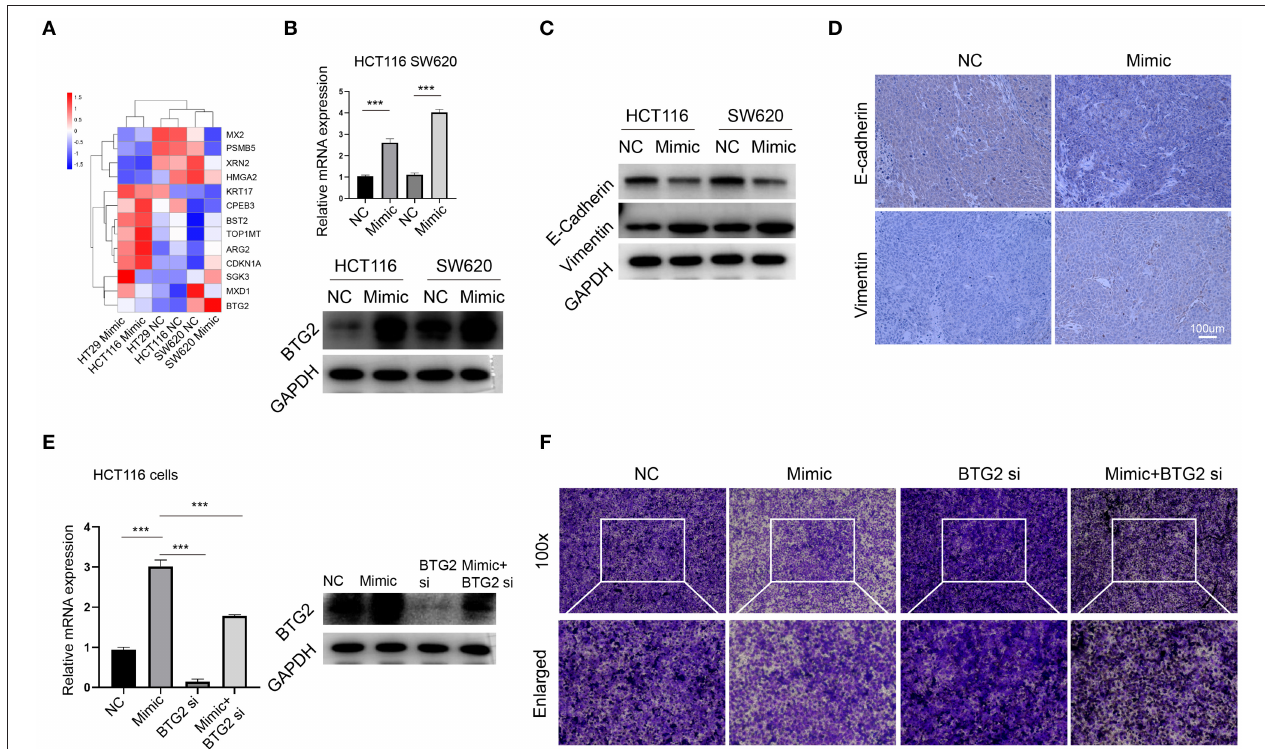
FIGURE 7 | miR-1278 inhibits migration through upregulation of BTG2. (A) Compare the expression of 13 genes consistently altered in three CRC cell lines presented by heat map. (B) The mRNA expression of protein expression of BTG2 was determined by qRT-PCR and Western blotting in HCT116 and SW620 cells. (C,D) Western blot analysis and IHC staining of e-cadherin and vimentin demonstrated that EMT was inhibited in the miR-1278 mimic group compared to the control group. (E) qRT-PCR and Western blot showed that BTG2 siRNA successfully knockdown BTG2 and rescued the expression of it promoting by miR-1278 mimic in HCT116 cells. (F) BTG2 siRNA largely rescued the inhibition of migration exerted by miR-1278 mimic in HCT116 cells. NC, negative control; Mimic, miR-1278 mimic; si, BTG2 siRNA; *** P <